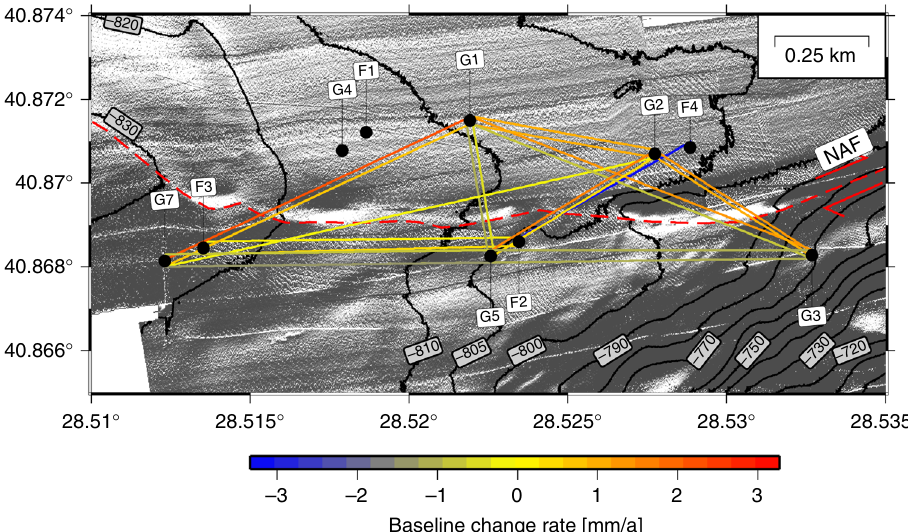
Fig. 2 Map of the geodetic network on the sea fl oor. Baseline shortening or lengthening rates, based on the total deformation measured at the end of the deployment, are colour coded. A constant strain of 4.5 × 10 − 6 was subtracted to each baseline in order to correct for the inferred constant salinity decrease of 0.002 PSU yr − 1 . Transponder locations are shown as black circles. F- and G- stations only communicate within their respective network. High-resolution shaded bathymetry map 26,27 is shown with a light source from the